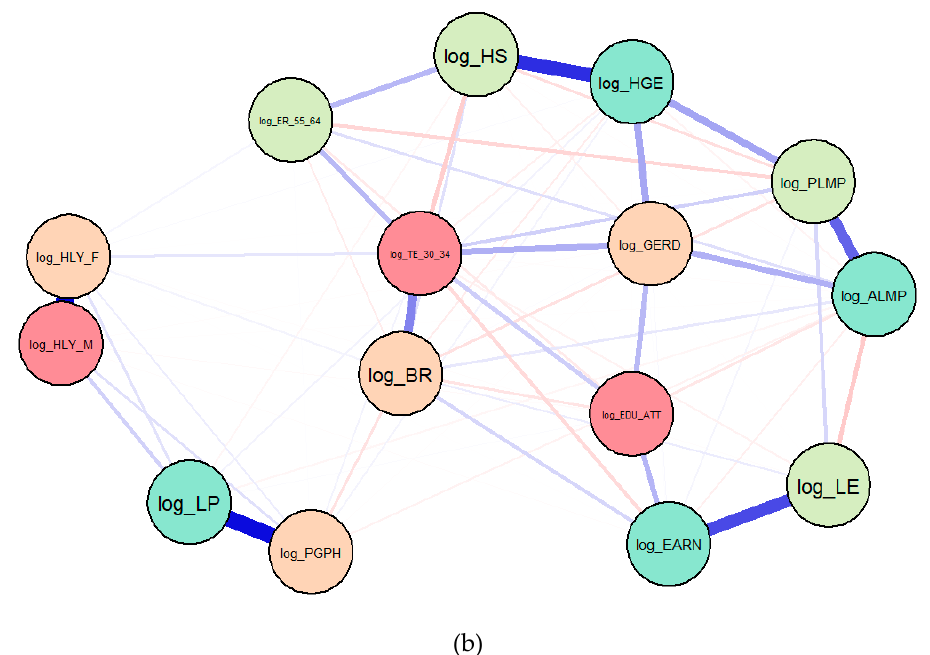
(b) Figure A1. GGMs (Gaussian graphical models), 1995–2017, extended Bayesian information criterion (EBIC), and least absolute shrinkage and selection operator (LASSO): ( a ) EU-13; ( b ) EU-15. Source: Authors’ research in R. Table A6. Results of macroeconometric models deployed for H 1 , EU-13 and EU-15, 1995–2017. EU-13